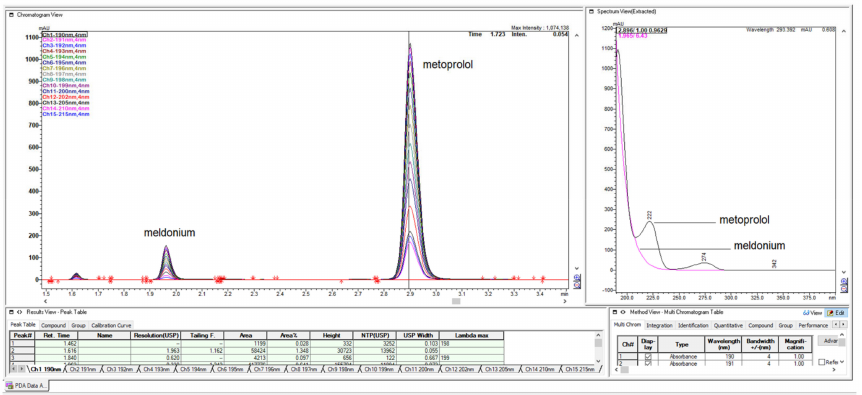
Figure 28. Chromatograms with Zorbax CN-SB-250 × 4.6 mm with 50% ACN and 50% 13 mM (0.15% w / v ) NH 4 H 2 PO 4 and overlaid 15-channels of different UV-absorbing wavelengths.